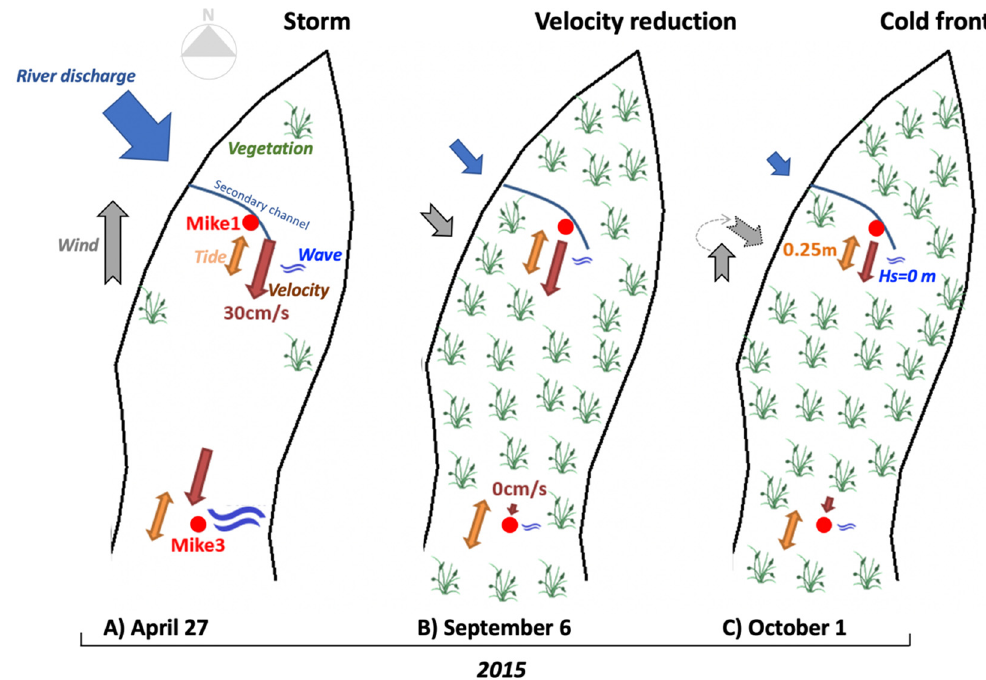
Figure 13. Conceptual diagram describing the climatic and hydrological events controlling sediment deposition and transport in Mike Island (Wax Lake Delta, Louisiana) in 2015: ( A ) storm event, ( B ) water velocity reduction due to vegetation interference and ( C ) cold front.